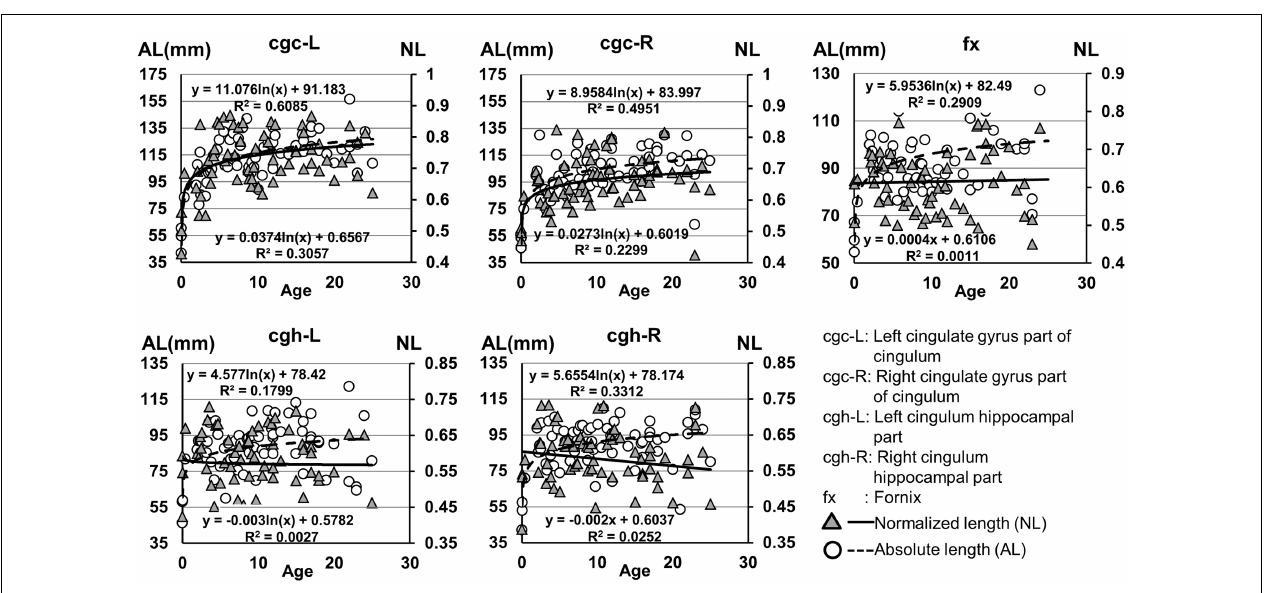
FIGURE 7 |Age-dependent changes of absolute and normalized fiber length of limbic tracts . R 2 and fitting equations are listed in each panel.